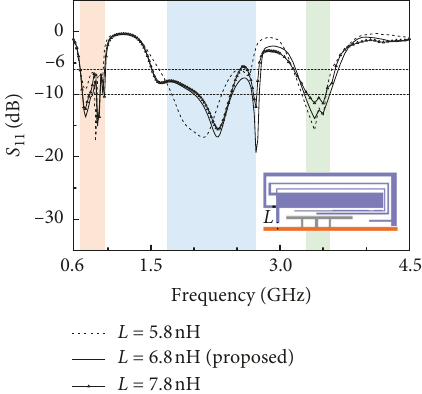
11 for the different antennas.